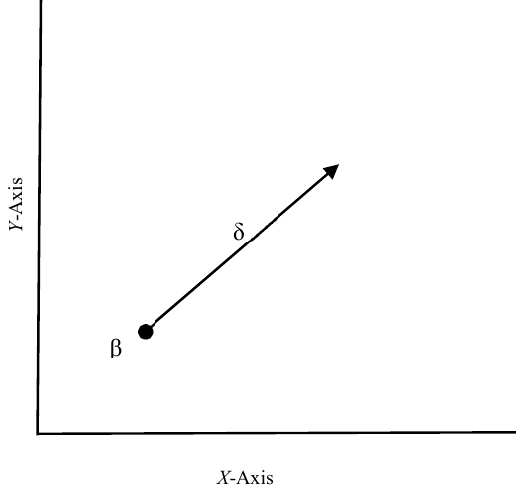
Figure 2. The differential β and base vector δ provide the optimal direction.